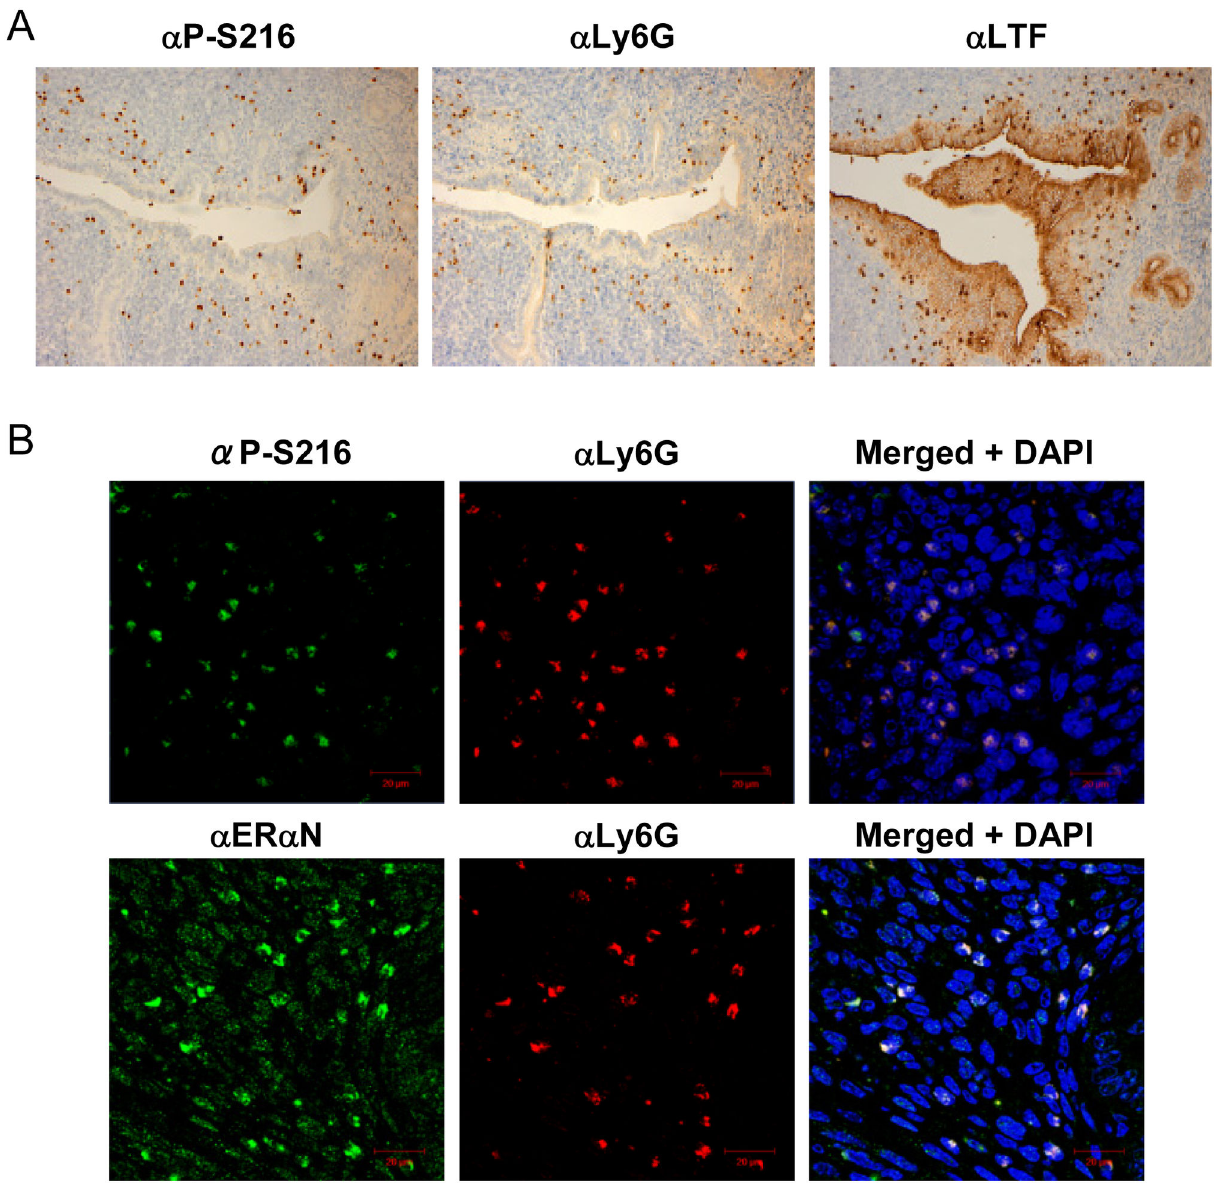
Figure 2. Phosphorylated ERα in infiltrating neutrophils. (A) Serial sections of the uterus at the estrus stage were stained by αP-S216, anti-Ly6G (αLy6G) or anti-lactoferrin (αLTF) antibody. (B) Uterine sections were double stained with αLy6G antibody and either αP-S216 or αERαN antibody. αLy6G was visualized by Texas red-conjugated second antibody; while fluorescein-conjugated antibody was used to visualize αP-S216 and αERαN. DAPI stains